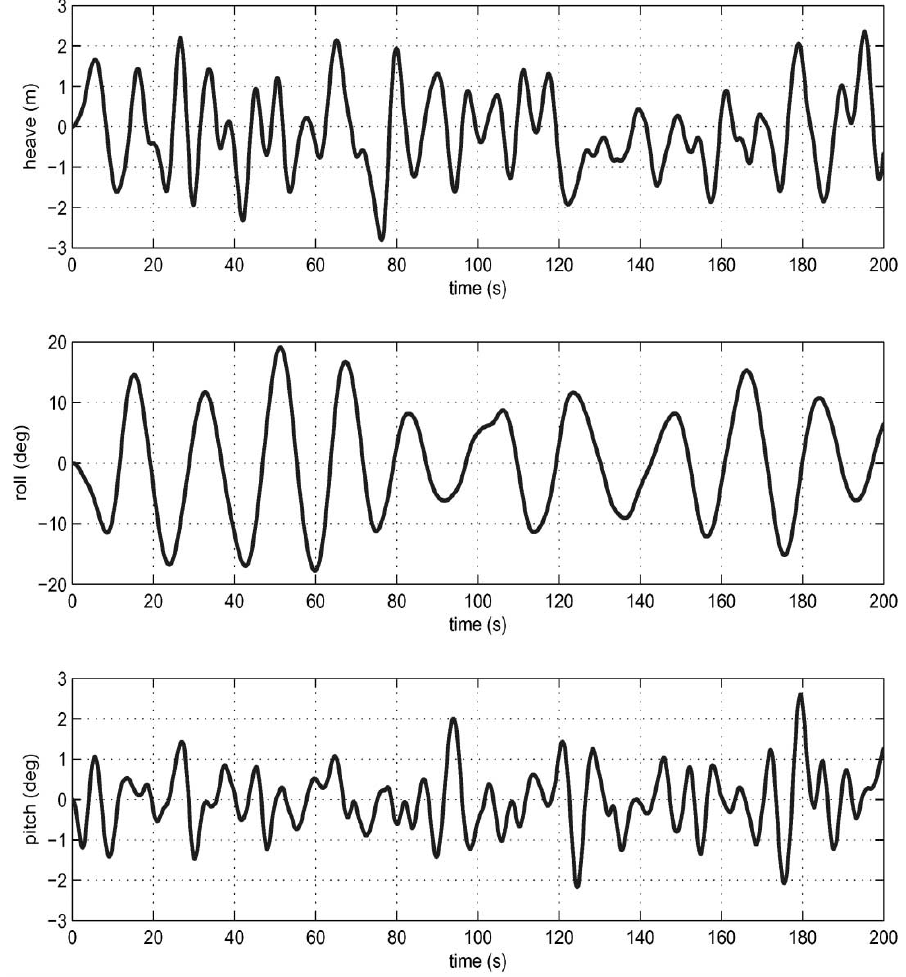
Figure 11. Heave position (m), roll angle (deg) and pitch angle (deg) versus time simulated in Simulink using VERES data. Lateral